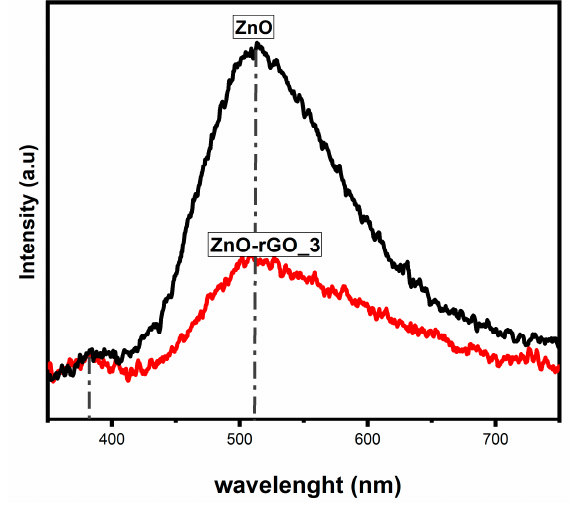
Figure 13. Photoluminescence spectra of ZnO and ZnO-rGO_3.